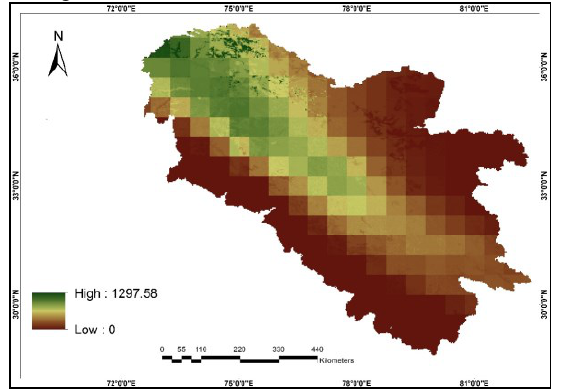
Figure 15. SWE (in mm) map for NWH river basins.